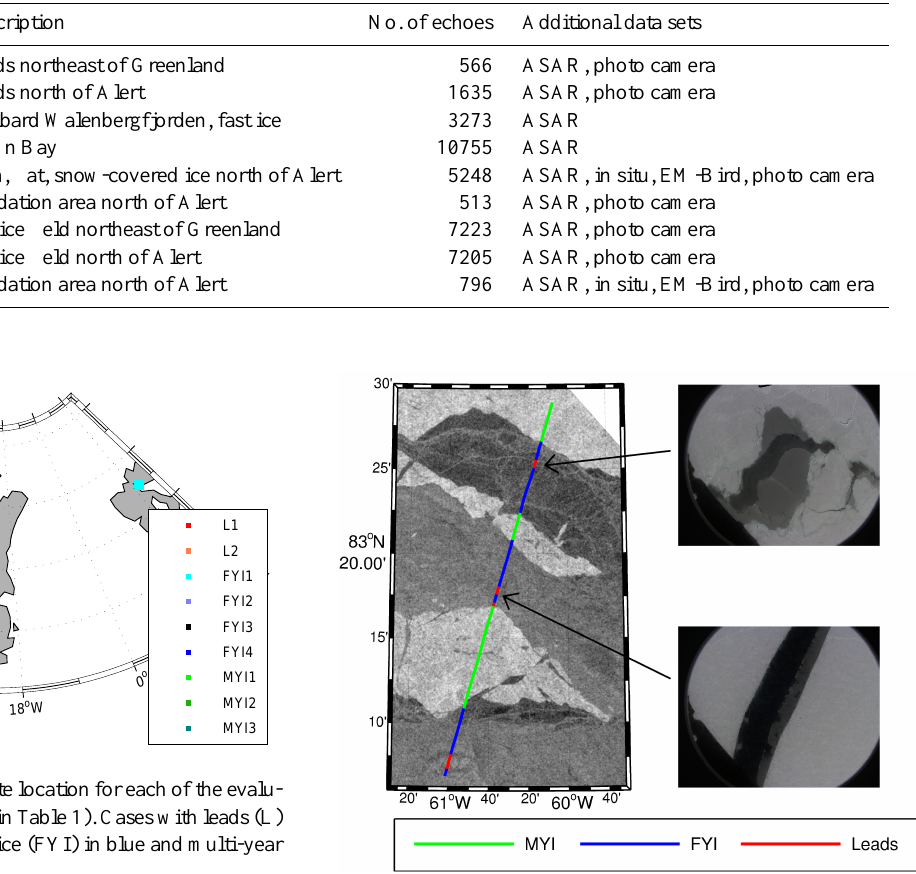
Fig. 2: Example of background information available to retrieve sea ice type north of Alert. Left: Envisat ASAR Wide Swath image overlaid with contemporary ASIRAS track from May 1 2008. In green the ASIRAS track over MYI is shown, in blue FYI and in red the leads. Right: Example of camera images used for identifying leads within the ice.